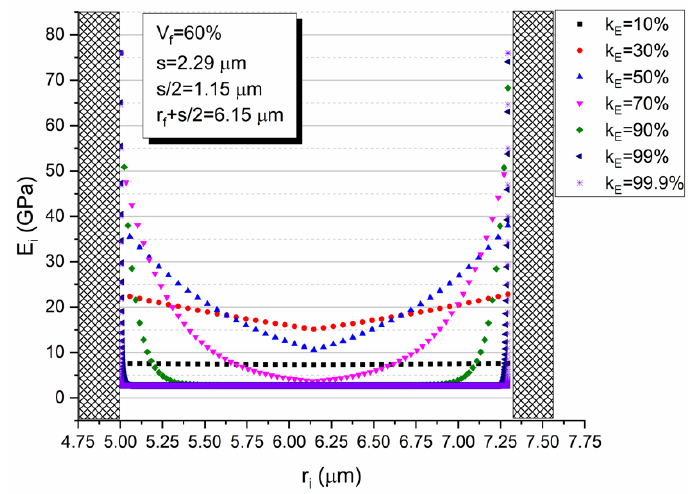
Figure 5. Interphase modulus variations within the interphasial area between two adjacent E-glass fibers for different values of the adhesion efficiency coefficient k E .